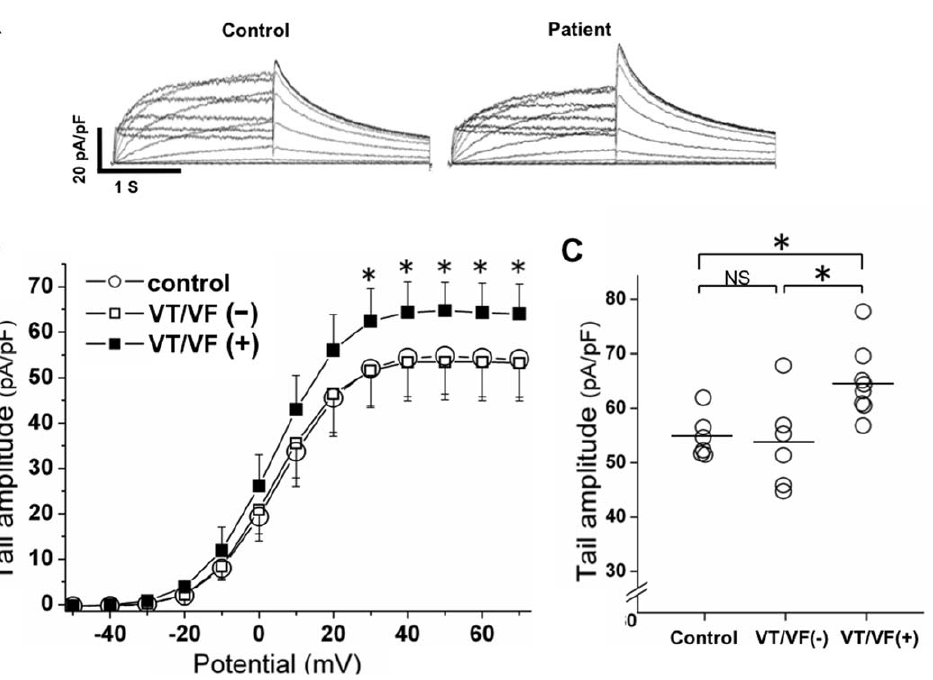
Figure 1. Effect of serum obtained from HF patients with ventricular tachyarrhythmia on KCNH2 currents in HEK 293 cells. A. Representative traces from a single cell cultured in a medium supplemented with 2% serum of a control subject (left) and medium supplemented with 2% serum of a patient with sustained VT (Case No. 1) (right). B. Current-voltage relationships of KCNH2 tail currents. Mean values of peak KCNH2 tail current densities were calculated by averaging the tail amplitude of each subject obtained from cells (n=8 to 11 cells) exposed to respective sera. Open circles show the results for controls (n=6), open squares show the results for HF patients without VT and VF (VT/VF ( 2 ), n=6) and closed squares show the results for HF patients with VT/VF (VT/VF ( + ), n=8). * P , 0.05: VT/VF ( + ) vs. control and VT/VF ( 2 ). C. Maximum values of peak tail current in the groups. * P , 0.05: VT/VF ( + ) vs. control and VT/VF ( 2 ). NS indicates not significant.